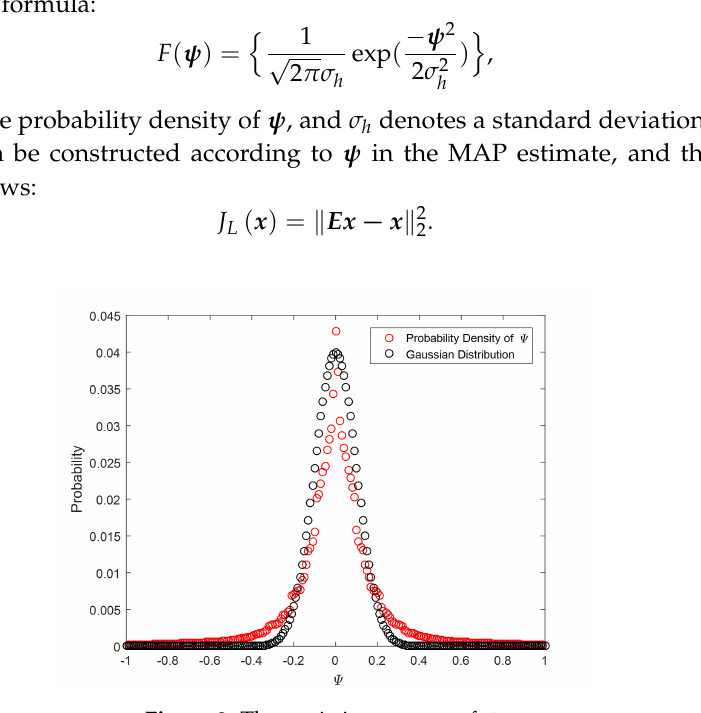
Figure 2. The statistic property of ψ